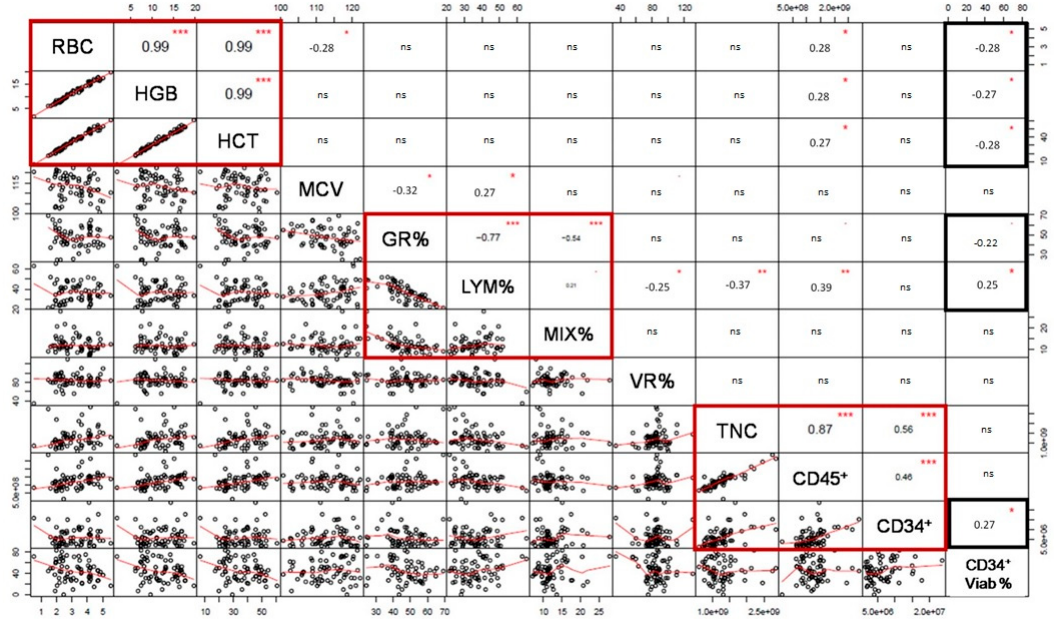
Figure 3. Correlation matrix using pre-cryopreservation variables and CD34 + cell viability after thawing (CD34 + Viab %). The matrix shows significance levels in the opposite squares to the correlated